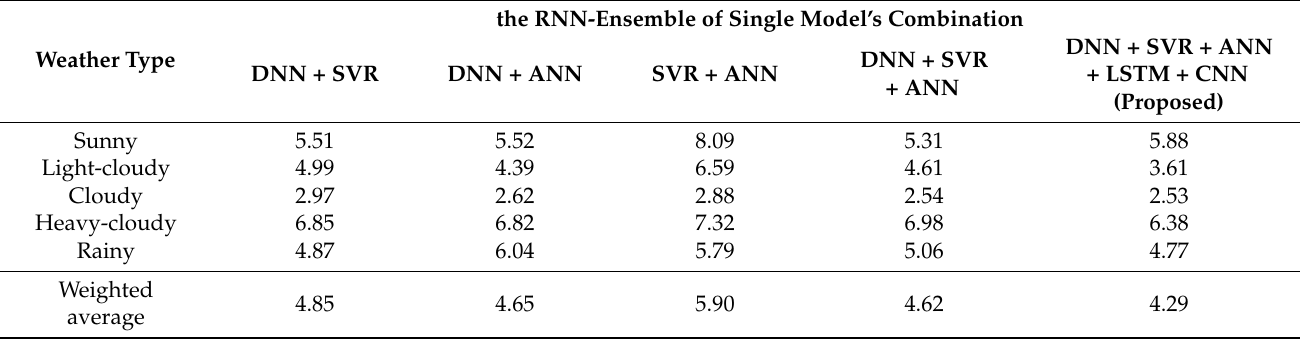
Table 9. Three-day ahead hourly forecasting performance (MAE) for different combinations of the single model in kW.